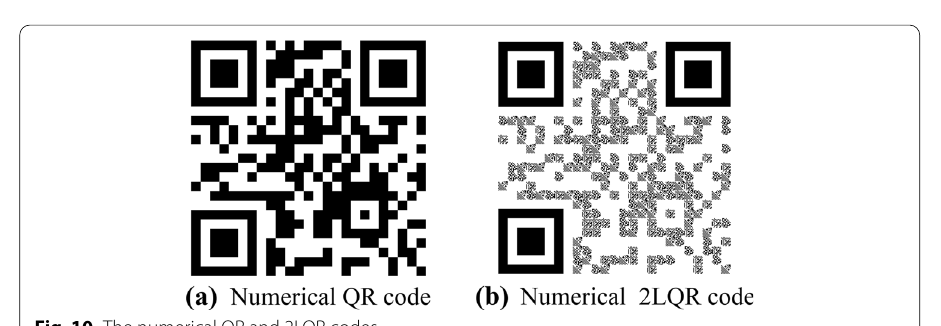
Fig. 10 The numerical QR and 2LQR